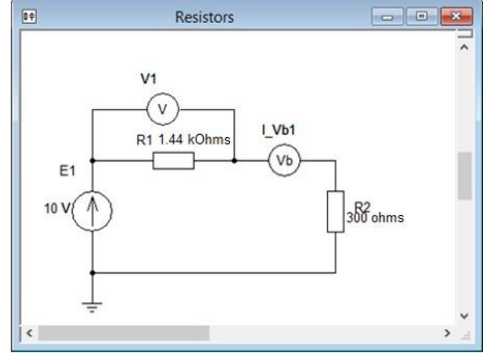
Fig. 4. Object layer of the Ohm's Law TIM 1. A model of the electric circuit is created in the object layer of the circuit editor.